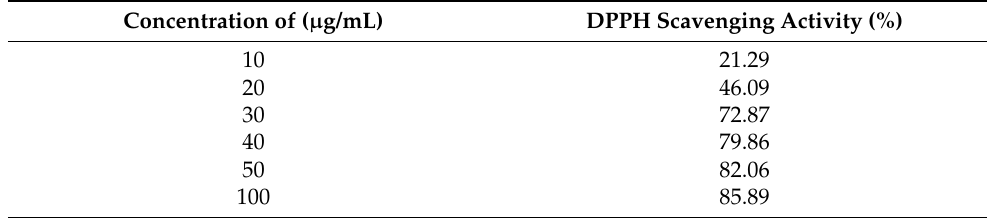
Table 1. DPPH scavenging assay of SIE.